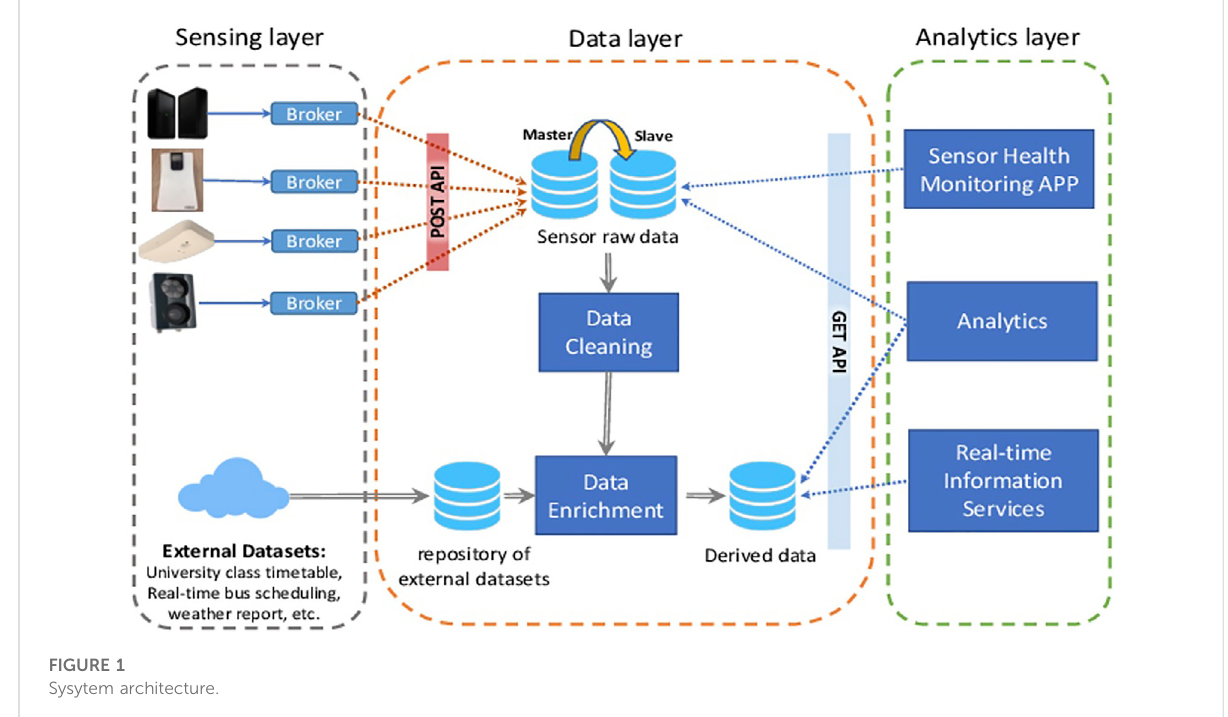
FIGURE 1 Sysytem